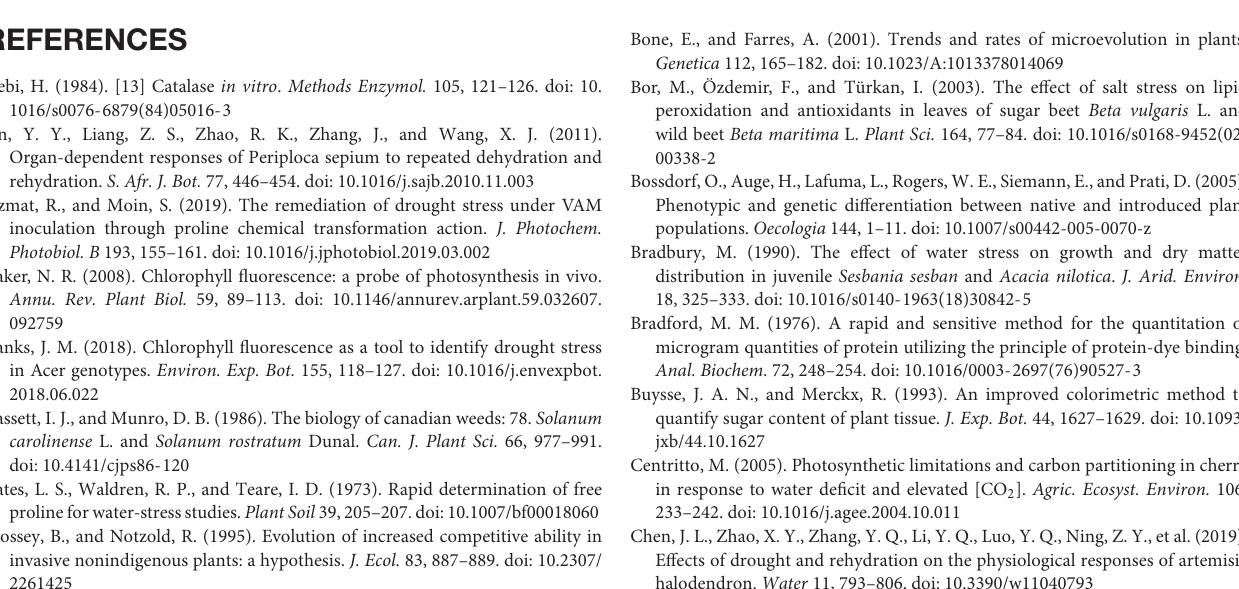
Supplementary Figure 1 | Pearson’s correlation coefficient ( r ) for the relationships among the physiological characteristics for different geographical populations of S. rostratum under the control condition. (A) GC site; (B) TKX site; (C) KL site; and (D) WNT site. ∗∗∗ and ∗∗ indicate significant differences at p < 0.001 and p < 0.01 levels, respectively. Supplementary Figure 2 | Pearson’s correlation coefficient ( r ) for the relationships among the physiological characteristics for different geographical populations of S. rostratum under light drought stress (LD) conditions. (A) GC collected site; (B) TKX site; (C) KL site; and (D) WNT site. ∗∗∗ and ∗∗ indicate significant differences at p < 0.001 and p < 0.01 levels, respectively. Supplementary Figure 3 | Pearson’s correlation coefficient ( r ) for the relationships among the physiological characteristics for different geographical populations of S. rostratum under moderate drought stress (MD) condition. (A) GC site; (B) TKX site; (C) KL site; and (D) WNT site. ∗∗∗ and ∗∗ indicate significant differences at p < 0.001 and p < 0.01 levels, respectively. Supplementary Figure 4 | Pearson’s correlation coefficient ( r ) for the relationships among the physiological characteristics for different geographical populations of S. rostratum under severe drought stress (SD) condition. (A) GC collected site; (B) TKX collected site; (C) KL collected site; and (D) WNT collected site. ∗∗∗ and ∗∗ indicate significant differences at p < 0.001 and p < 0.01 levels, respectively. Supplementary Table 1 | List of non-standard abbreviations. Supplementary Table 2 | List of related trait features and calculation formula. Supplementary Table 3 | ANOVA outputs for individual and interactive effects of population and drought-stress treatment on plant functional traits, chlorophyll fluorescence, antioxidant enzyme activity, and osmoregulatory